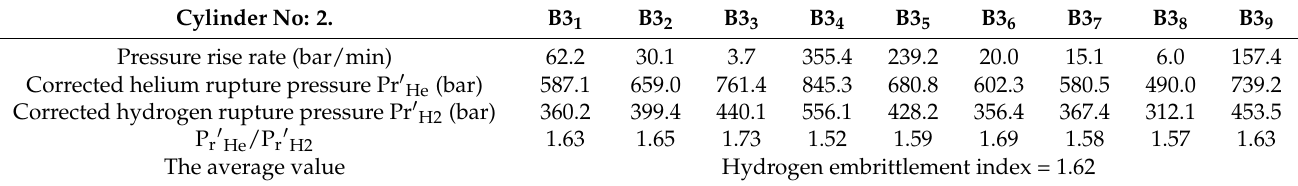
Table 5. The P r (cid:48) He /P r (cid:48) H2 ratio for the body-shoulder